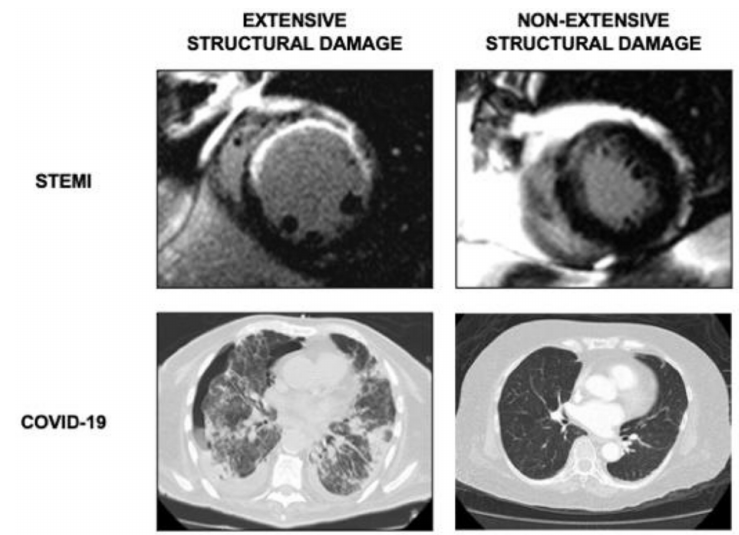
Figure 2. Extension of structural damage. In STEMI patients (upper panel), CMR images of extensive (left) and non-extensive (right) infarct size. In COVID-19 patients (lower panel), CT studies of bilateral (left) and unilateral (right) pneumonia. CMR: cardiac magnetic resonance. COVID-19: coronavirus disease 2019. CT: computed tomography. STEMI: ST-segment elevation myocardial